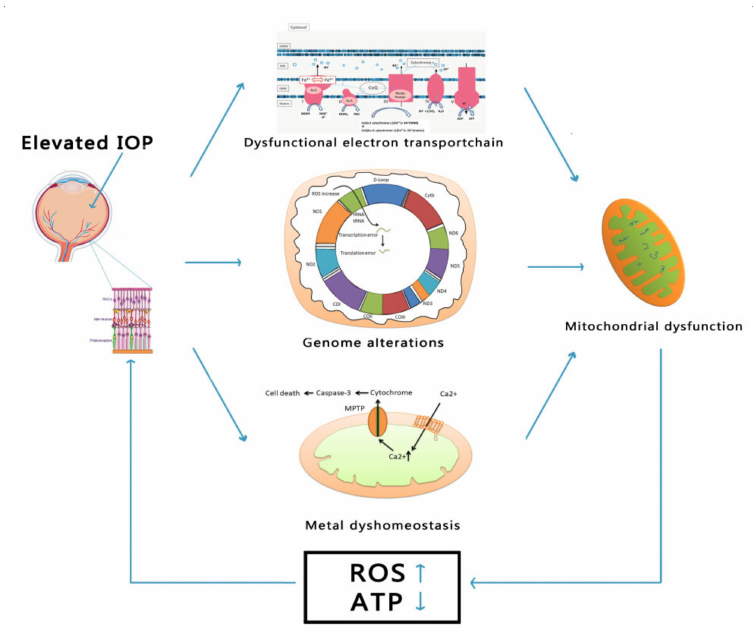
Figure 2. Relationship between elevated intraocular pressure and mitochondrial dysfunction. El- evated IOP caused mitochondrial electron transport chain dysfunction, mitochondrial genome alterations and metal dyshomeostasis, leading to mitochondrial dysfunction that increased ROS and decreased ATP which can give rise to axon damage of